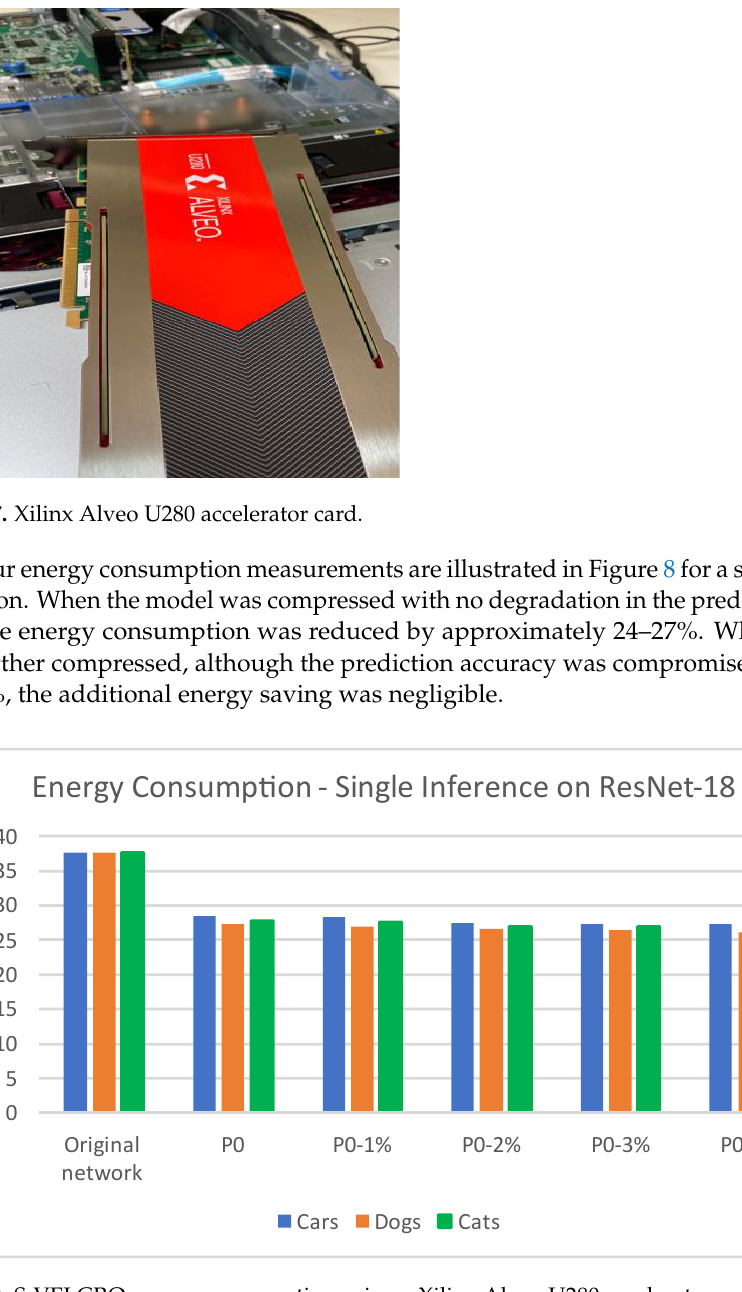
Figure 8. S-VELCRO energy consumption using a Xilinx Alveo U280 accelerator card.